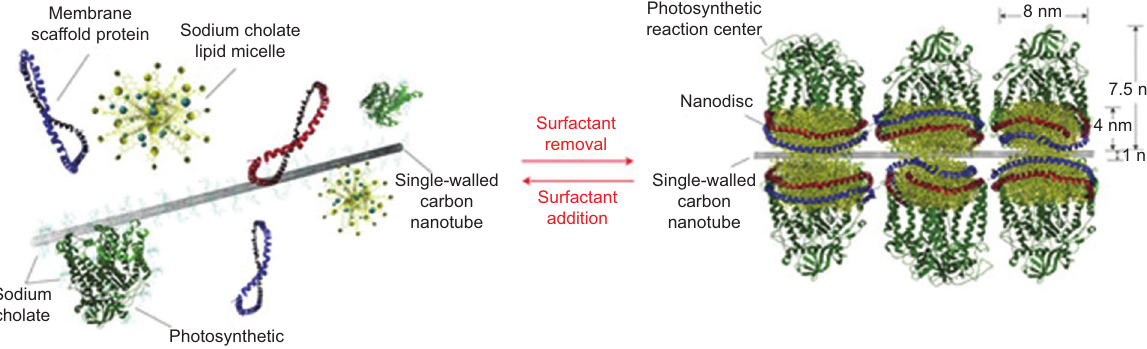
Figure 22 Schematic representation of the reversible self-assembly process (reprinted with permission from [114]). Copyright 2010, Mac- millan Publisher Ltd: Nature